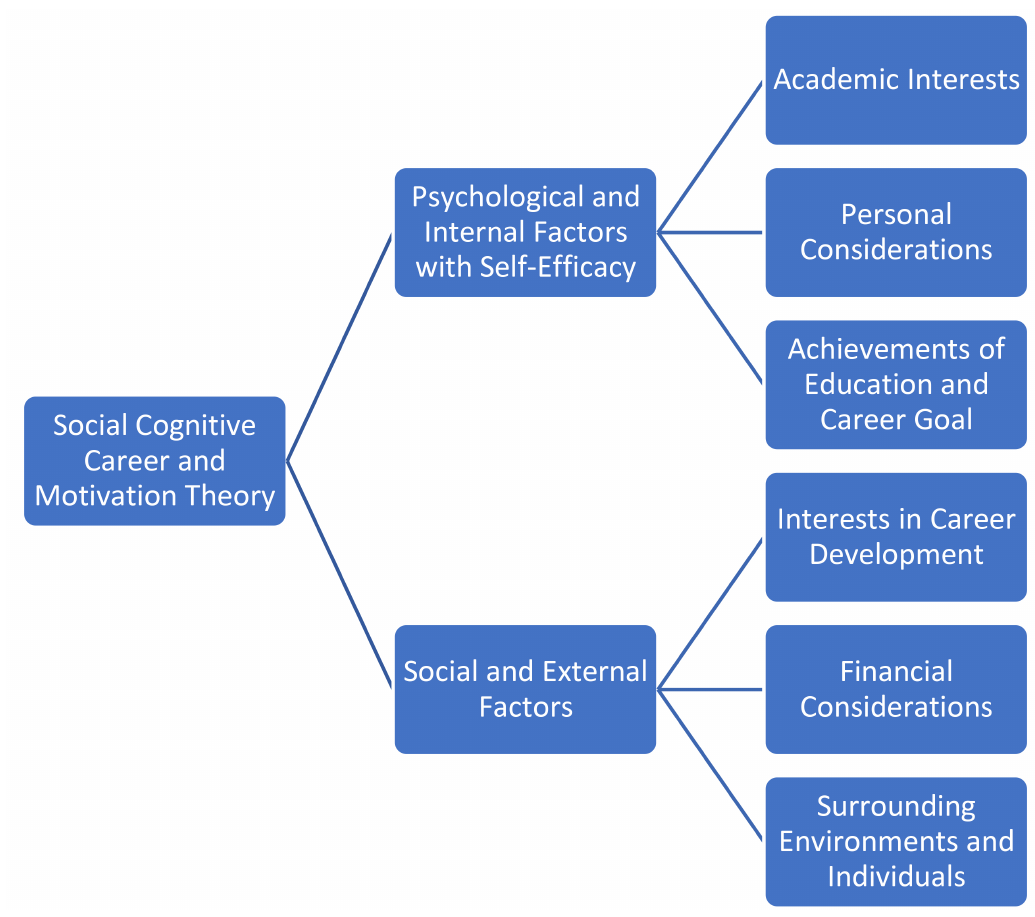
Fig. 1. Social cognitive career and motivation theory